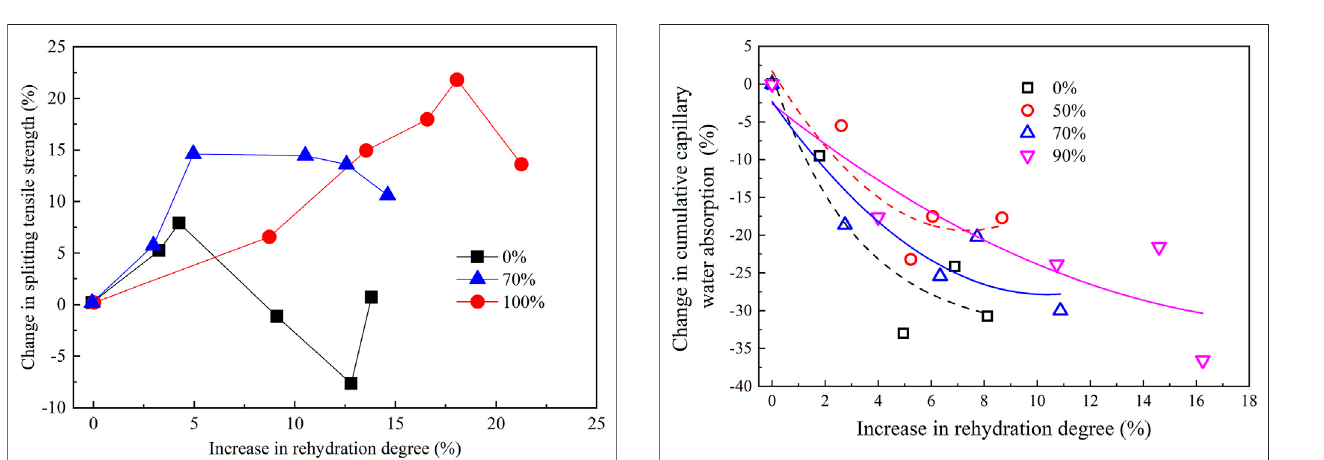
FIGURE 13 | Relationship between the splitting tensile strength of UHPC-2 and its rehydration degree.